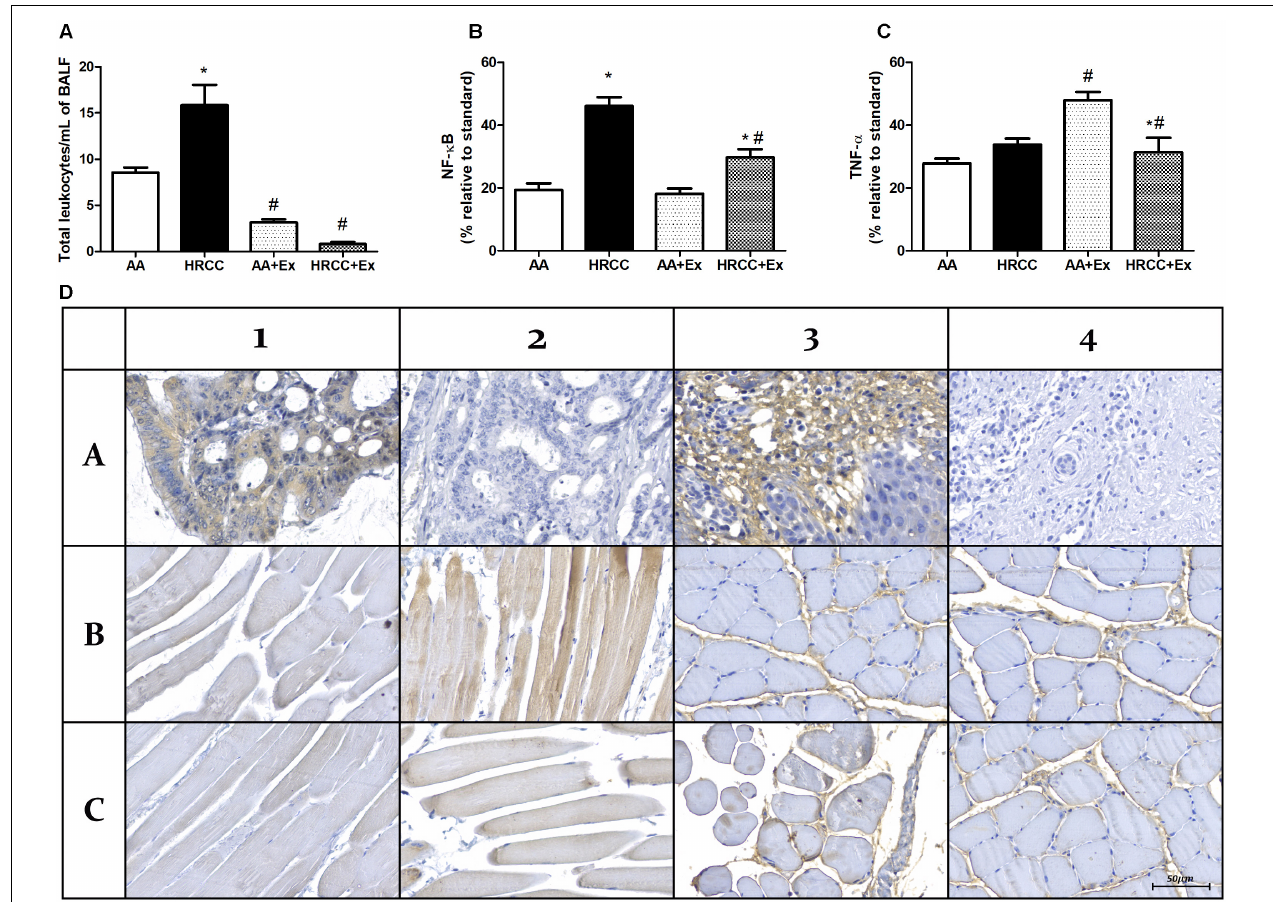
FIGURE 3 | Effect of combined exercise on inflammatory parâmeters of mice exposed to hand-rolled cornhusk cigarette (HRCC) smoke. The number of total leukocytes in Lavage fluid (BALF) (A) are expressed as mean and standard error of the mean and were analyzed statistically using two-way ANOVA, followed by the Newman–Keuls test. The groups were considered different when p ≤ 0.05* (difference in relation to the ambient air, # difference in relation to HRCC). Percentage of inflammatory proteins immunoexpression in quadriceps of animals exposed to HRCC and combined exercise were selected from 25 images of four animals per group. The areas of immunopositivity for NF- κ B p105/50 (B) and TNF α (C) were expressed as percentage average relative to standard molecule and analyzed statistically using one-way ANOVA, followed by the Newman–Keuls test. The groups were considered different when the value of p was ≤ 0.05* (difference in relation to the ambient air, # difference in relation to HRCC). Representative images of immunohistochemical analysis of quadriceps of animals exposed to HRCC and combined exercise (D) . NF- κ B positive control (A1), NF- κ B negative control (A2), NF- κ B Ambient air (B1), NF- κ B HRCC (B2), NF- κ B AA+exercise (C1) NF- κ B HRCC+exercise (C2), (A3), TNF α negative control (A4), TNF α Ambient air (B4), TNF α HRCC (B4), TNF α AA+exercise (C3) TNF α HRCC+exercise